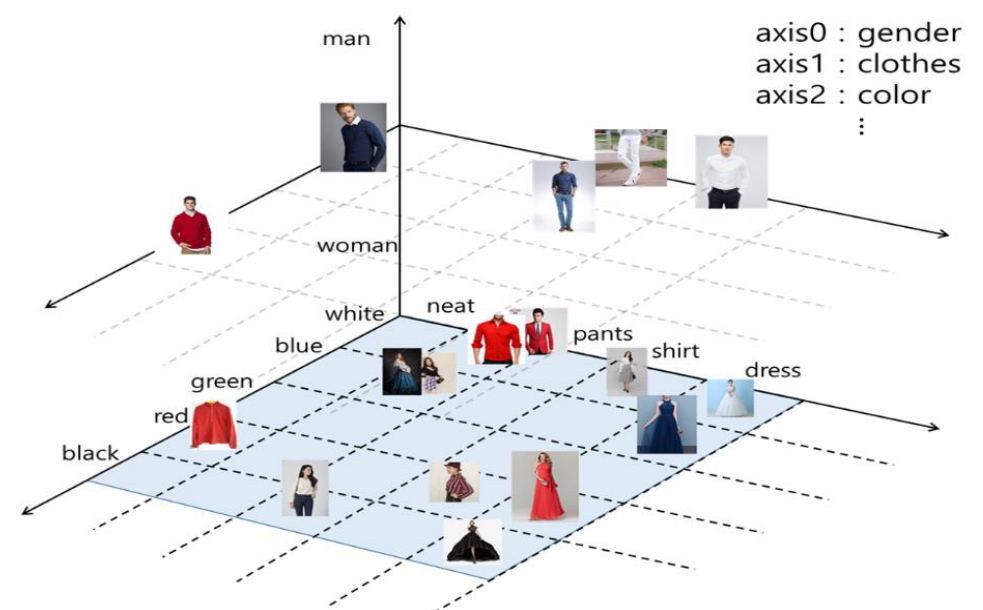
Figure 5. Fashion products with various attributes.